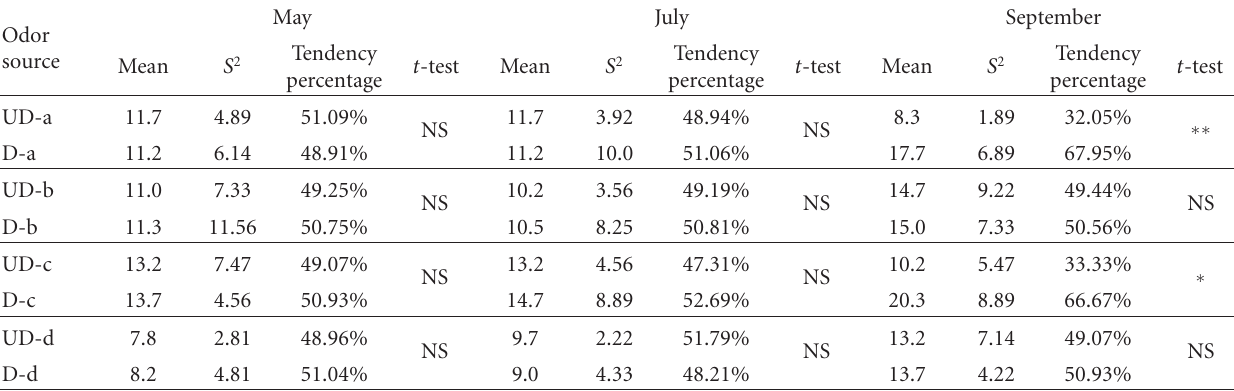
Table 1: The tropic response of C. sinica to persimmon leaves damaged (or undamaged) by Japanese wax scale at four di ff erent times of a day.